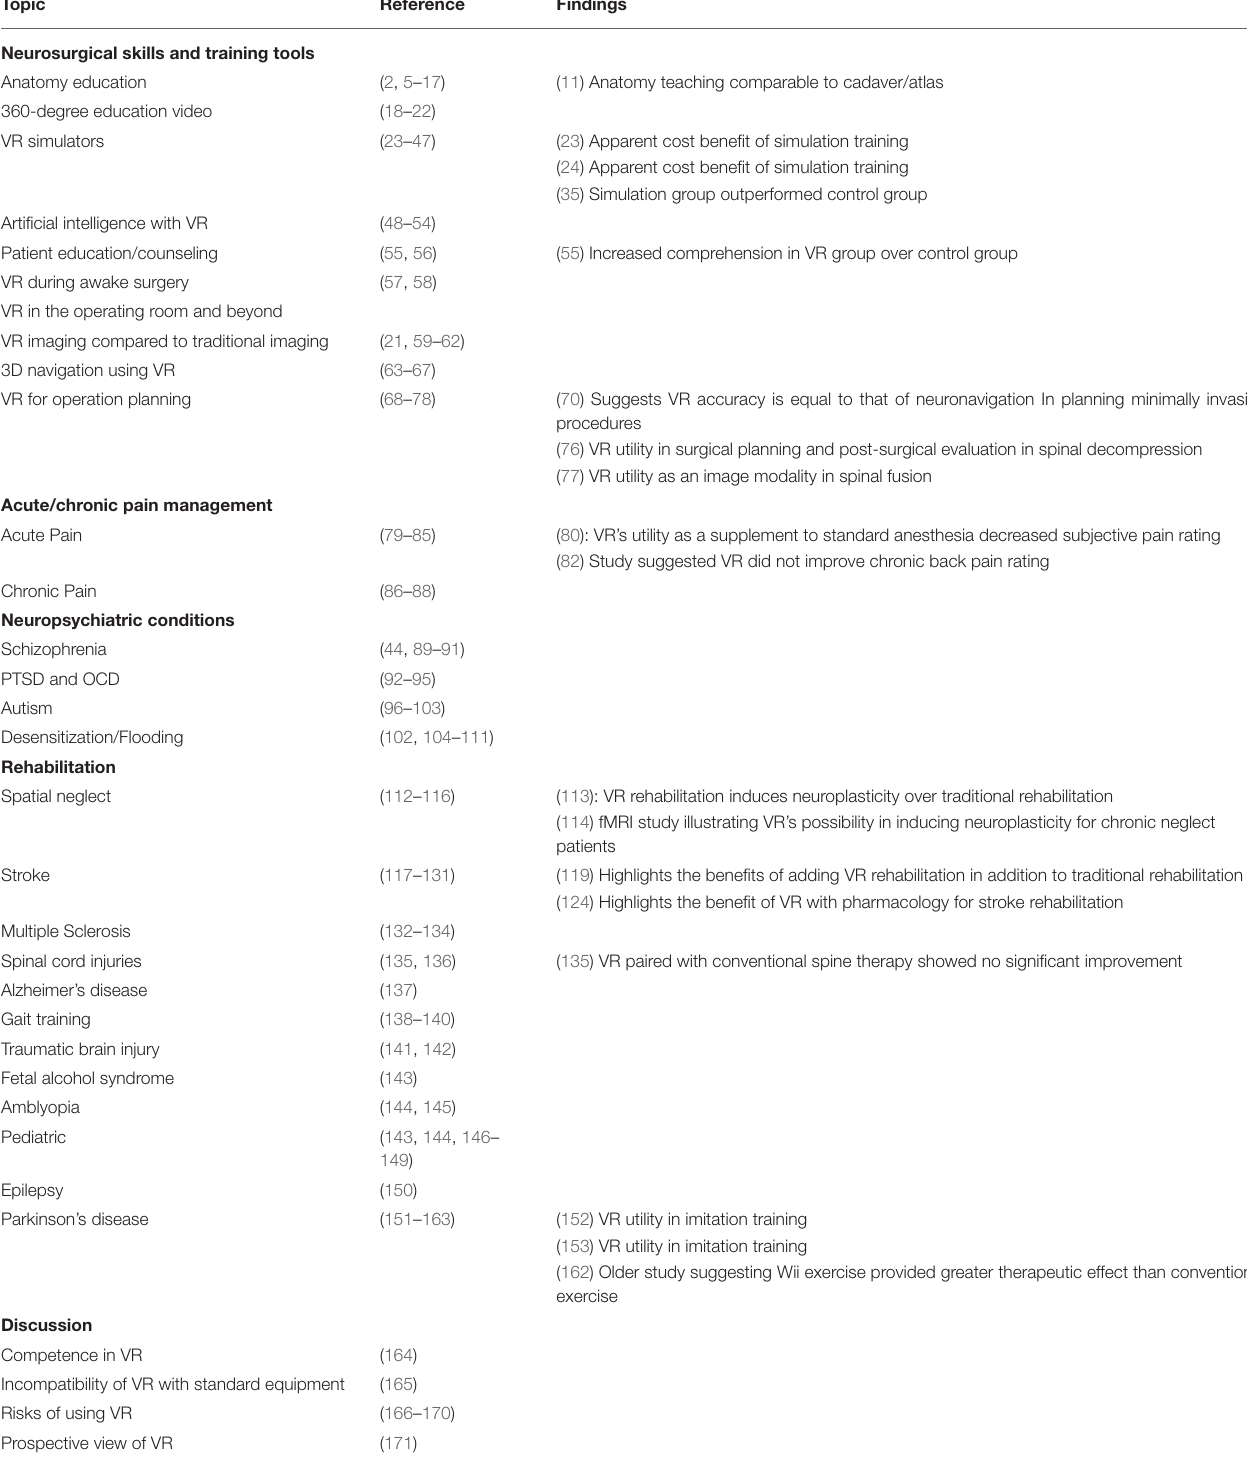
TABLE 2 | Summary table of findings and pathologies discussed in the referenced